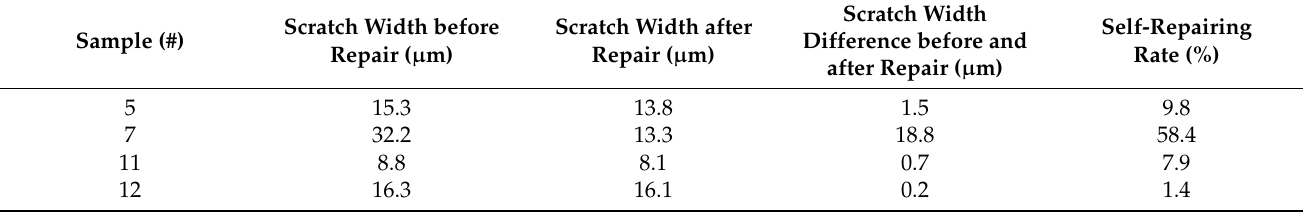
Table 5. Comparison of scratch gap width before and after self-repairing.